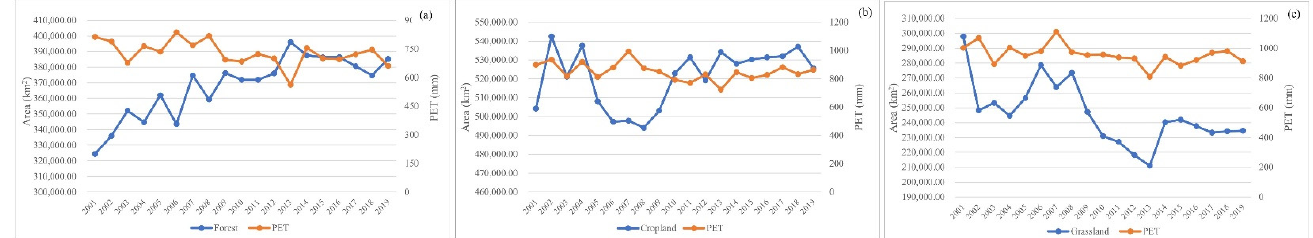
Figure 9. Time-series changes of land-use types and corresponding potential evapotranspiration (PET): ( a ) forest, ( b ) cropland, and ( c ) grassland.